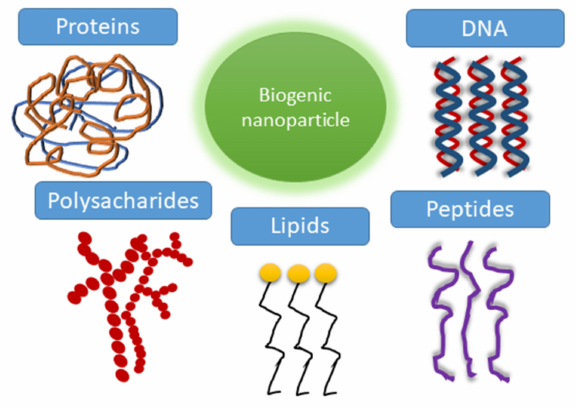
Figure 24. Classes of macromolecules involved in thermodynamic stabilization of biogenic